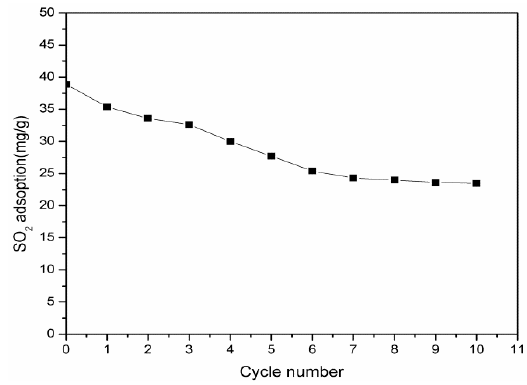
Figure 8. Sulfur capacity of the regenerated adsorbents, where 0–10 stands for number of cycles.